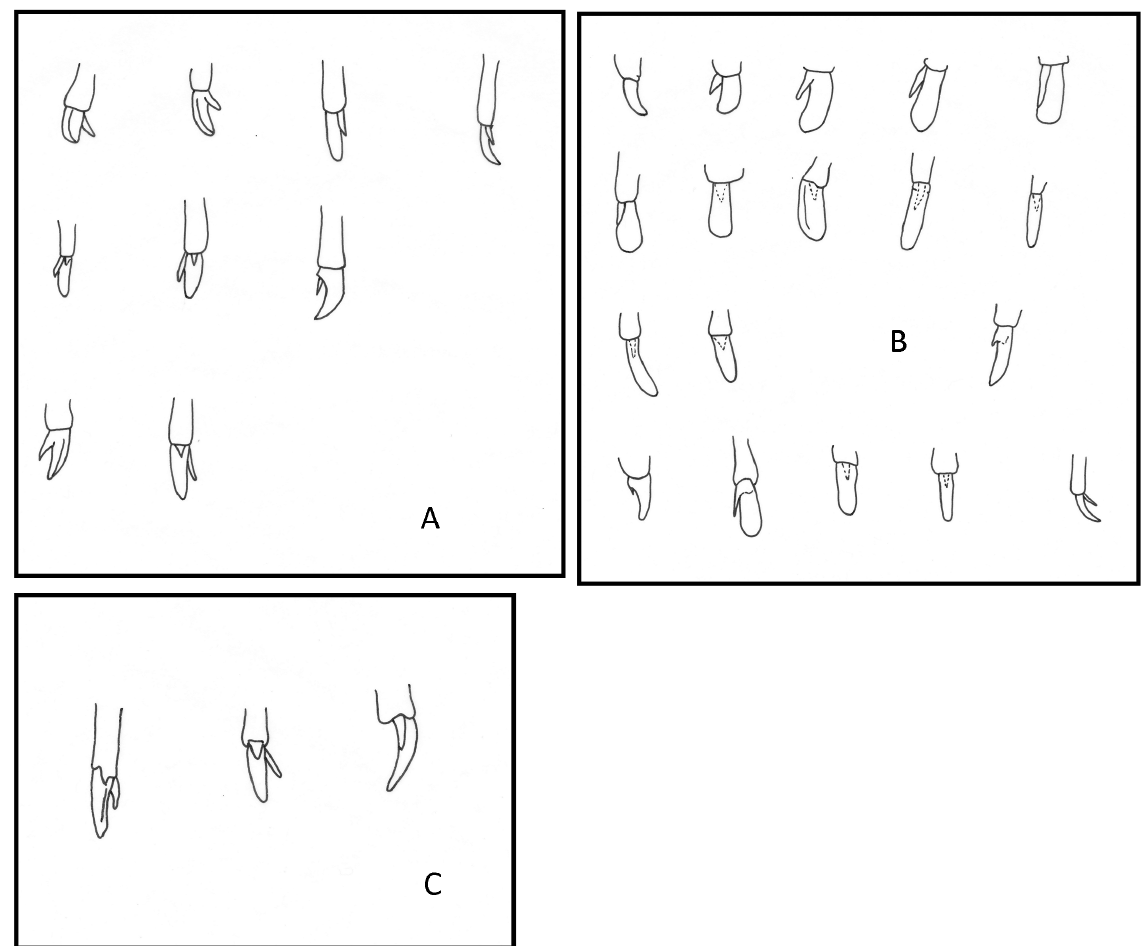
Fig. 9. Claws and accessory claws in the three species of Siphonophora Brandt, 1837 studied here. A . Siphonophora hebetunguis (Attems, 1951). B . Siphonophora setaepromissa sp. nov. C . Siphonophora tuberculata sp. nov. Not to